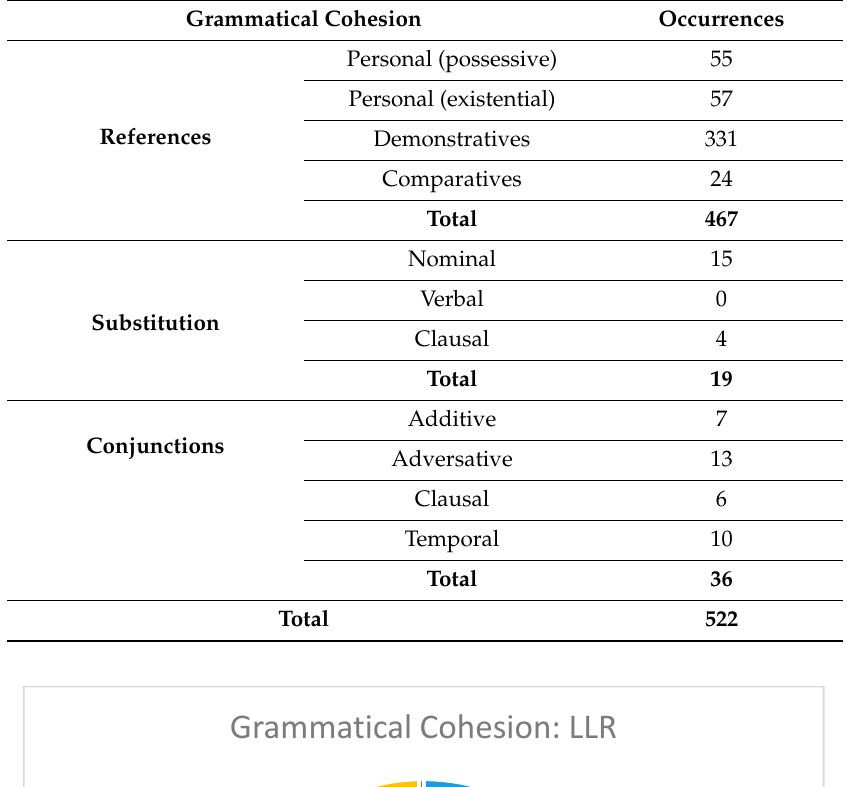
Table 15. Grammatical cohesion.